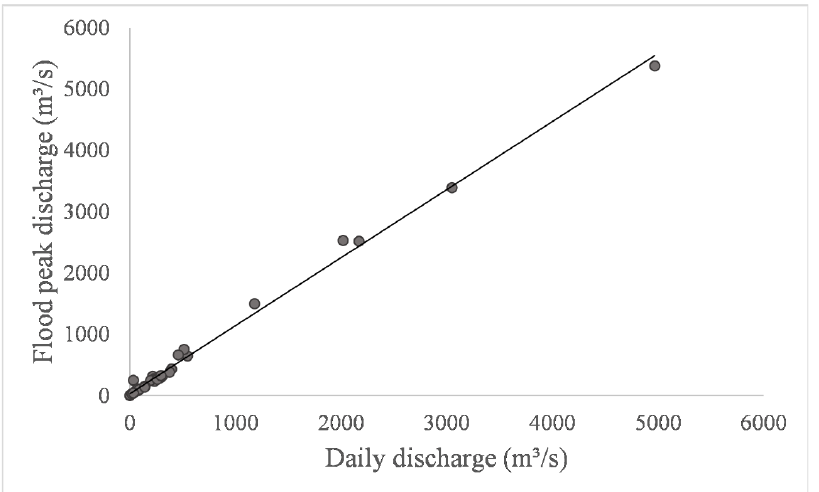
Figure 3. The relationship between flood peak discharge and daily discharge during the flooding events. Table 1. Daily discharges and the corresponding flood peak discharge in different return periods in the Zhulong river watershed (m 3